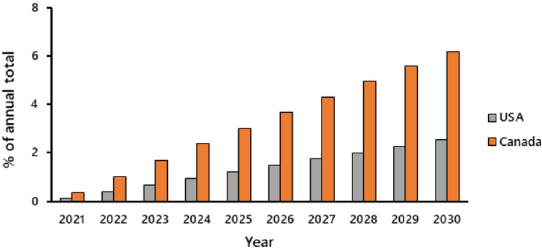
Fig 6. Projected annual percent contribution of net immigration to annual CO 2 emissions in Canada and the USA from 2021 to 2030 (uses USA emigration estimate 1 and assumes that both Canada and the USA attain an annual 3% reduction in 2005 emission levels [= 30% reduction by